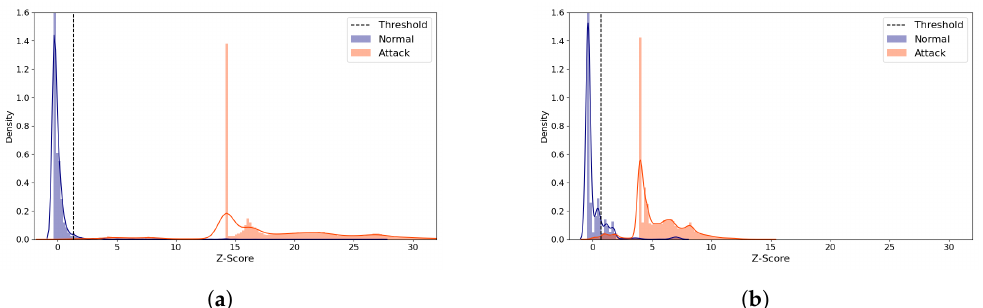
Figure 15. N-BaIoT Provision PT-737E Reconstruction Distance Distribution Density Plot (Normal and attack data) comparing the best and the worst performing cases when the (5,64) model was used. Blue denotes the normal data and orange denotes the attack data. A line depicts the kernel density estimated plot, and bar plot depicts the histogram. The dotted line indicates the threshold value, which divides the normal and the attack classes. The X-axis denotes Z -score. The Y-axis is density and limited to 1.6 for better visibility. ( a ) The best case (Latent Size = 29, MCC = 0.976, Threshold = 1.338). ( b ) The worst case (Latent Size = 1, MCC = 0.860, Threshold =